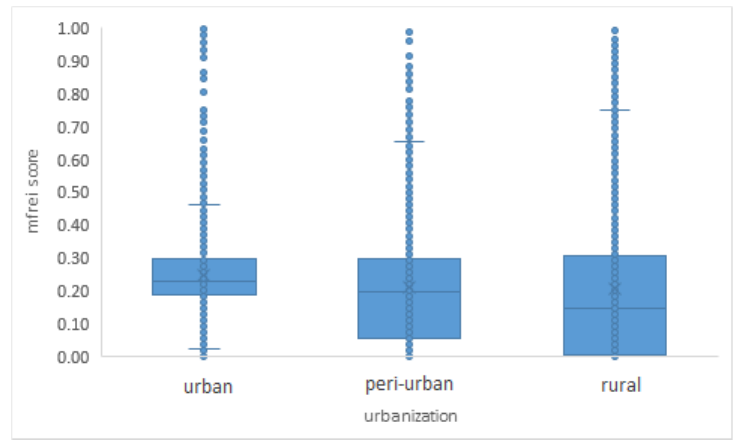
Figure 9. mFREI scores according to level of urbanization. The data is from 2020 and includes community gardens, farmers’ markets and farmers’ outlets .